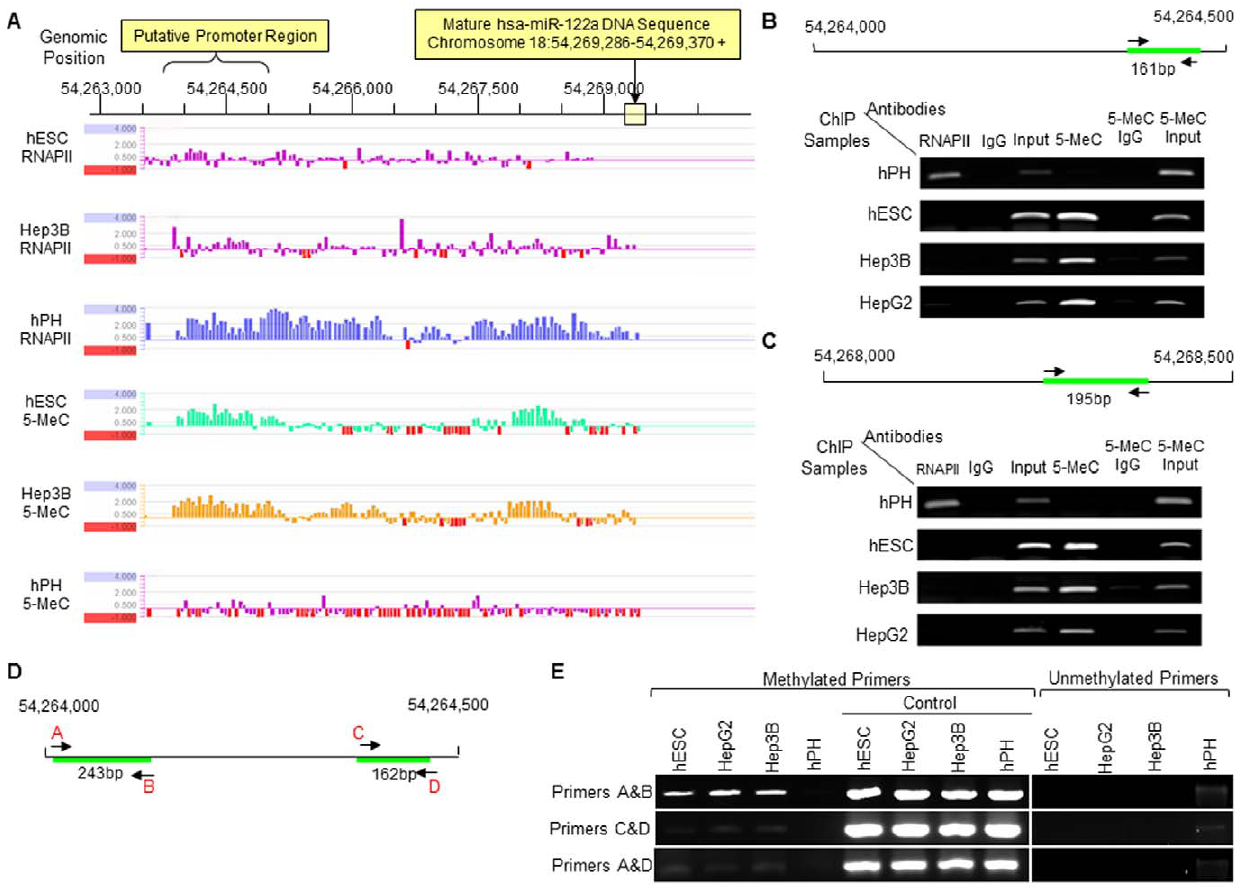
Figure 6. Methylation analysis of the genomic region upstream of miR-122 using ChIP-chip and bisulfite treatment. (A) High resolution map of RNAPII and 5-MeC binding sites on ChIP samples of hESCs, hPHs and Hep3B. The horizontal bar on the top of the figure indicates the genomic positions on chromosome 18, and the location of the mature miR-122 sequence in the genome is boxed in yellow. The predicted promoter sequence of miR-122 (Figure S4) is indicated above the horizontal bar with the genomic positions. ChIP-chip data are listed below the genomic position scale. Each vertical bar indicates the enrichment of a single probe as a log 2 ratio value between the enriched ChIP sample and the input sample. (B,C) The genomic regions that appear in Figure 6A to be bound by RNAPII in hPHs and methylated in hESCs and HCCs (18:54,264,000– 54,264,500 and 18:54,268,000–54,268,500) were verified by PCR. Arrows indicate the location of the primers, green bars indicate the amplified products, and the product sizes are listed below the green bars. (D) Diagram showing the predicted promoter region of miR-122 and primers used for amplification. The primers are indicated with letters A, B, C, D and colored in red. (E) PCR results showing that the methylation-specific primers amplifies the predicted promoter region (D) in hESCs and HCCs, while unmethylation-specific primers amplifies the same region in hPHs after bisulfite treatment. Control samples indicate hESCs, HCCs and hPHs that have not been bisulfite treated.